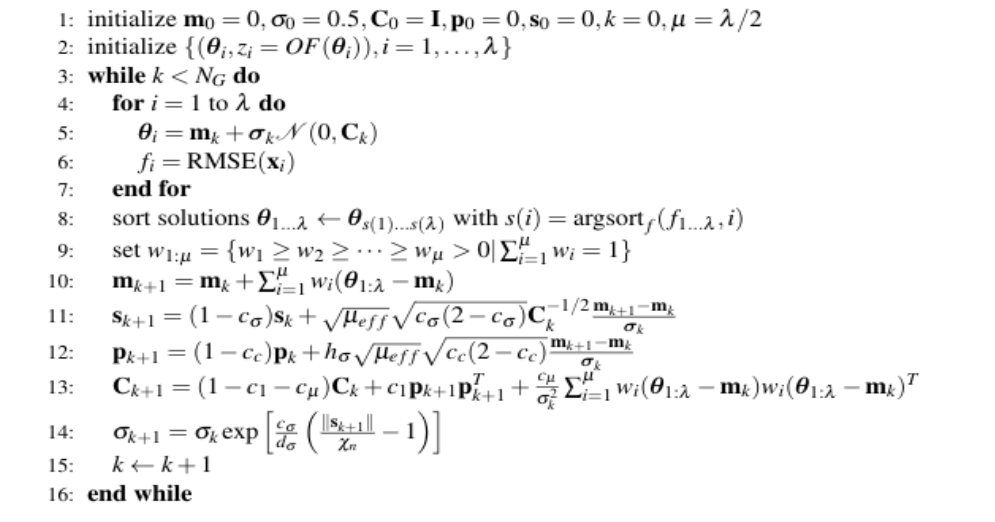
Table 5. Encoding of candidate solutions. The column IP indicates the internal parameter in the